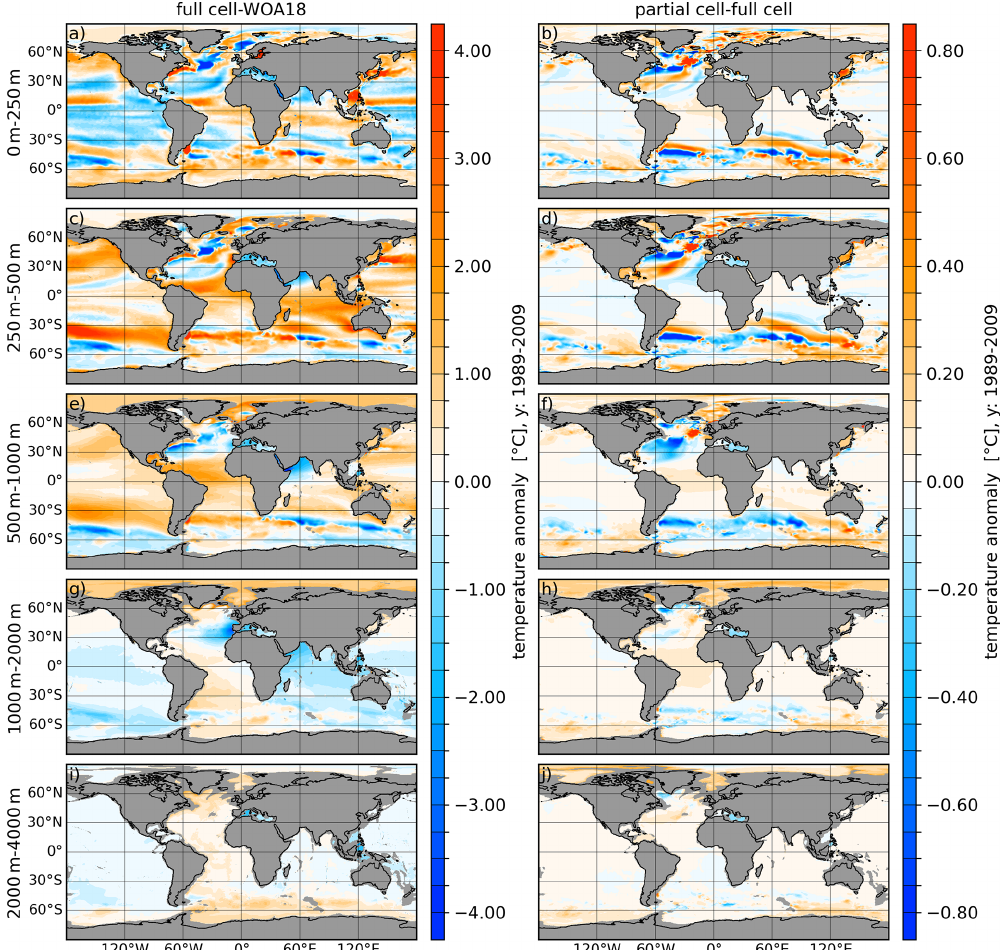
Figure 1. ( a, c, e, g, i ) Temperature biases of full cells referenced to the World Ocean Atlas 2018 (WOA18, Zweng et al., 2019) averaged over the period 1989–2009. ( b, d, f, h, j ) The temperature difference between partial and full cells (partial minus full). From top to bottom the panels show the vertically averaged fields for the depth ranges of 0–250, 250–500, 500–1000, 1000–2000 and